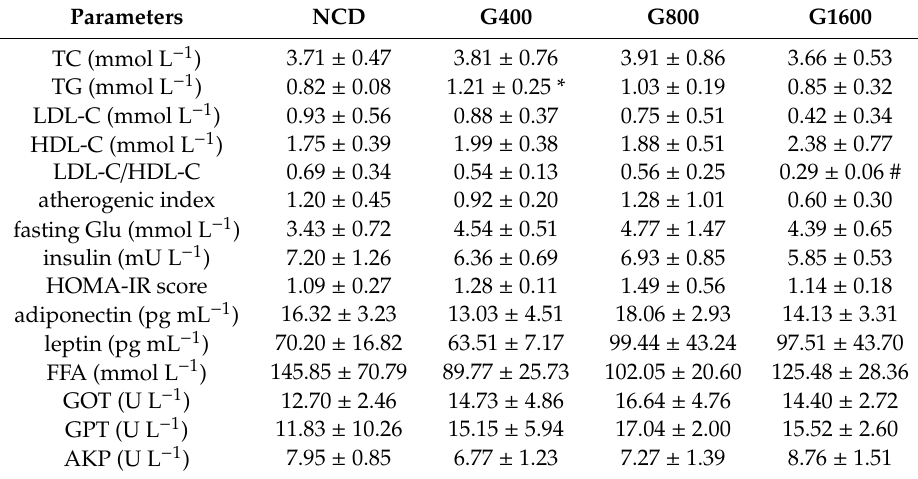
Table 1. E ff ect of GML on the metabolic-related biochemical